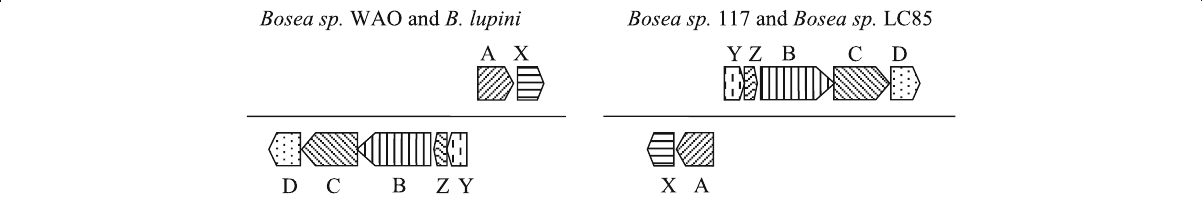
Fig. 10 Operon structure for the sox genes for thiosulfate oxidation. The orientation is 5 ′ -3 ′ with the plus strand on top. The orientation of the genes for Bosea sp. WAO and Bosea lupini are the same while Bosea sp. LC85 and Bosea sp. 117 have the same orientation. These operons are inverted between the plus and minus